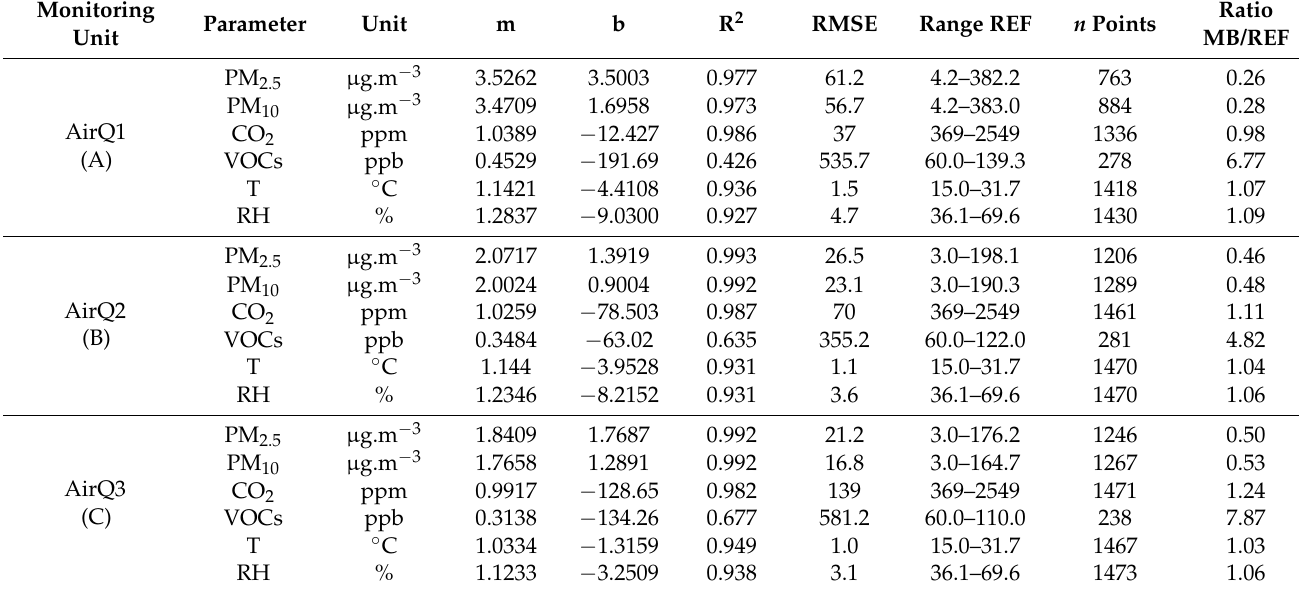
Table 1. Intercomparison results between MBs and the reference equipment for all the studied parameters. RMSE stands for root mean square error (assessed as described elsewhere [24]). Range REF stands for the range of the pollutant as measured by the reference equipment